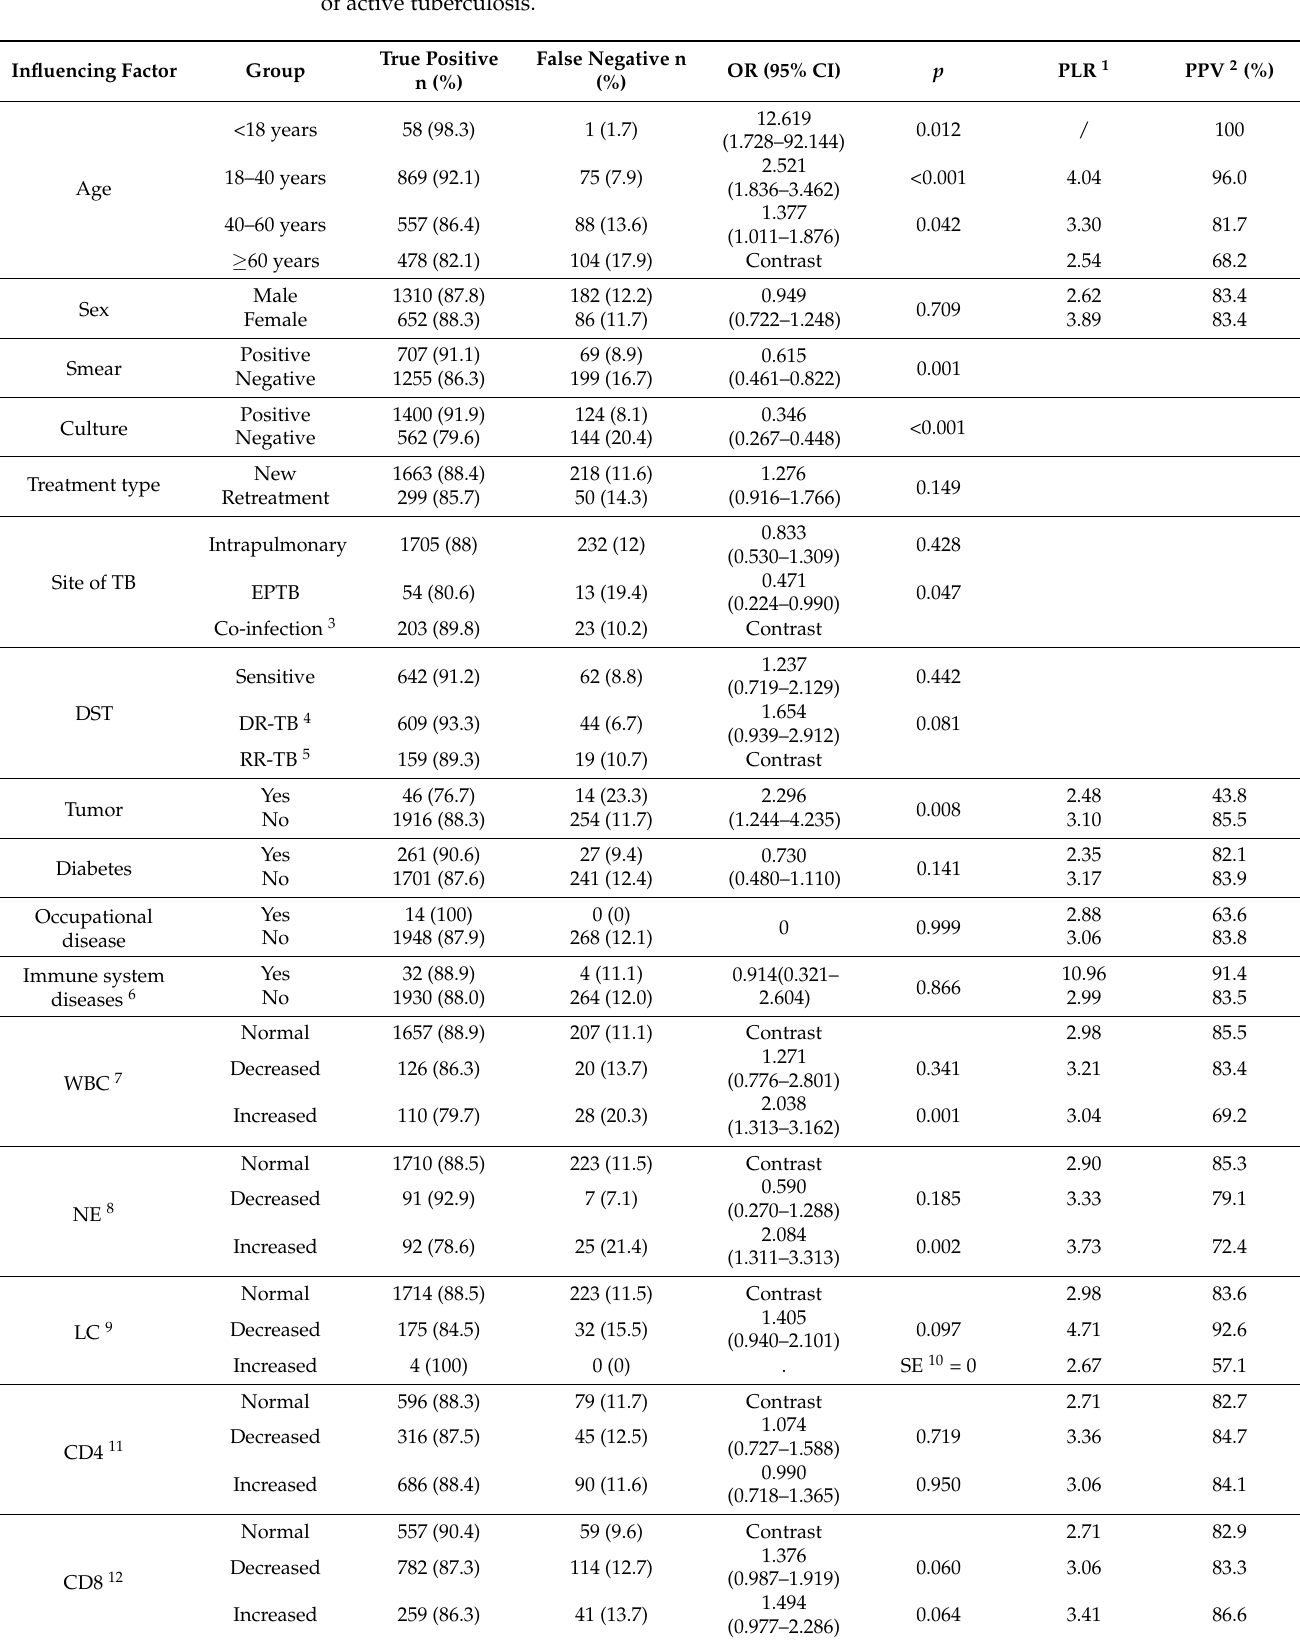
Table 2. Single-factor risk analysis of false-negative and true-positive QFT-GIT results in the diagnosis of active